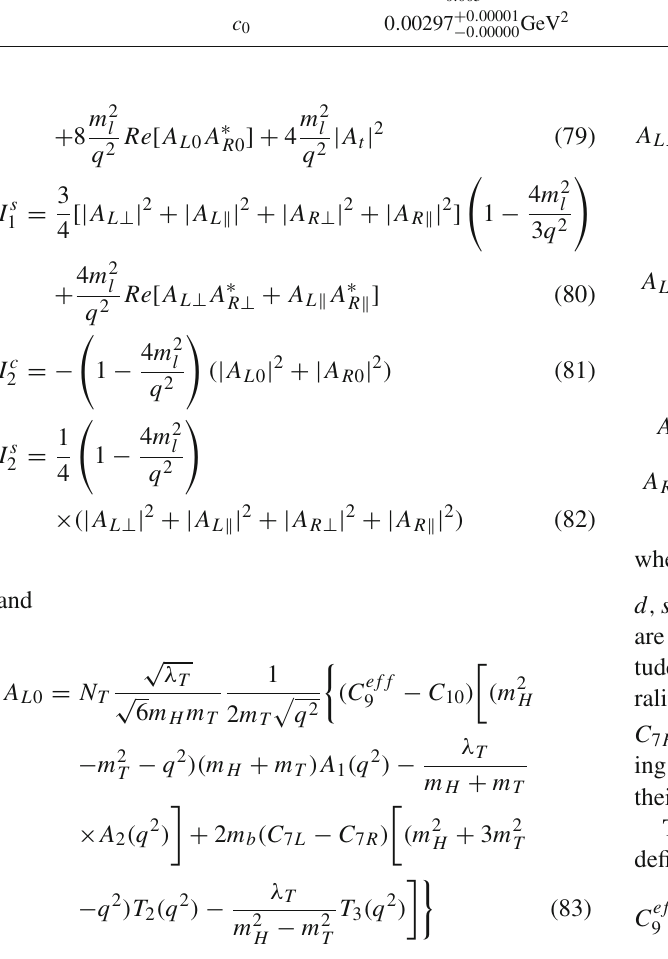
are the longitudinal, transverse and time-like decay ampli- tudes, respectively. The subscripts L and R denote the chi- rality of corresponding amplitudes. In the SM, C 7 L = C ef f C 7 R = m q C ef f . We adopt the Wilson coefficients up to lead- 7 m b ing logarithmic accuracy given by Ref. [26]. At the scale m b , their values are listed in Table